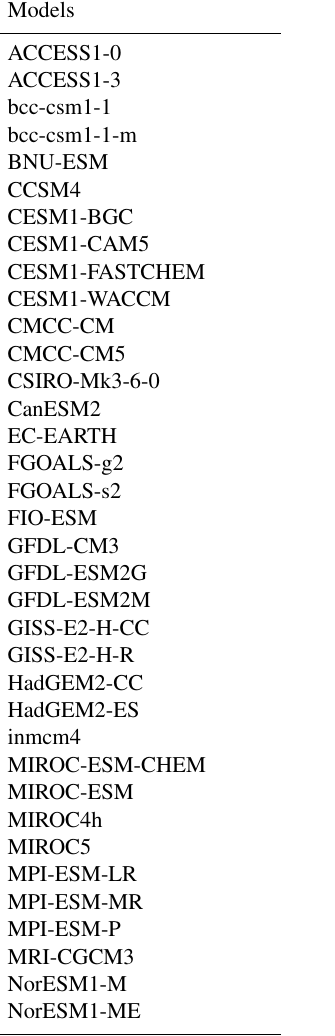
Table 1. List of CMIP5 models.